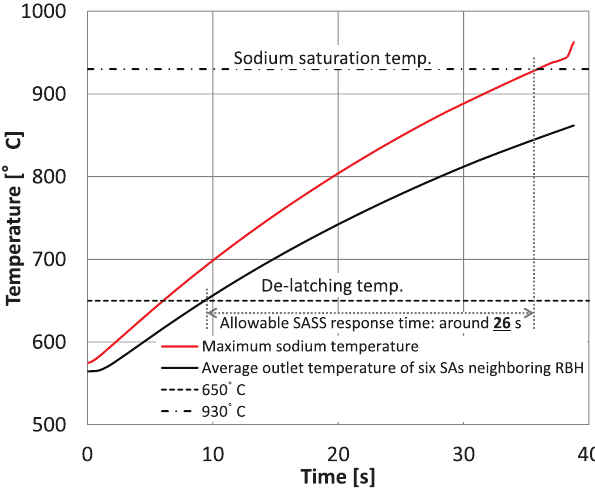
Fig. 3. Calculated temperature in ULOF.